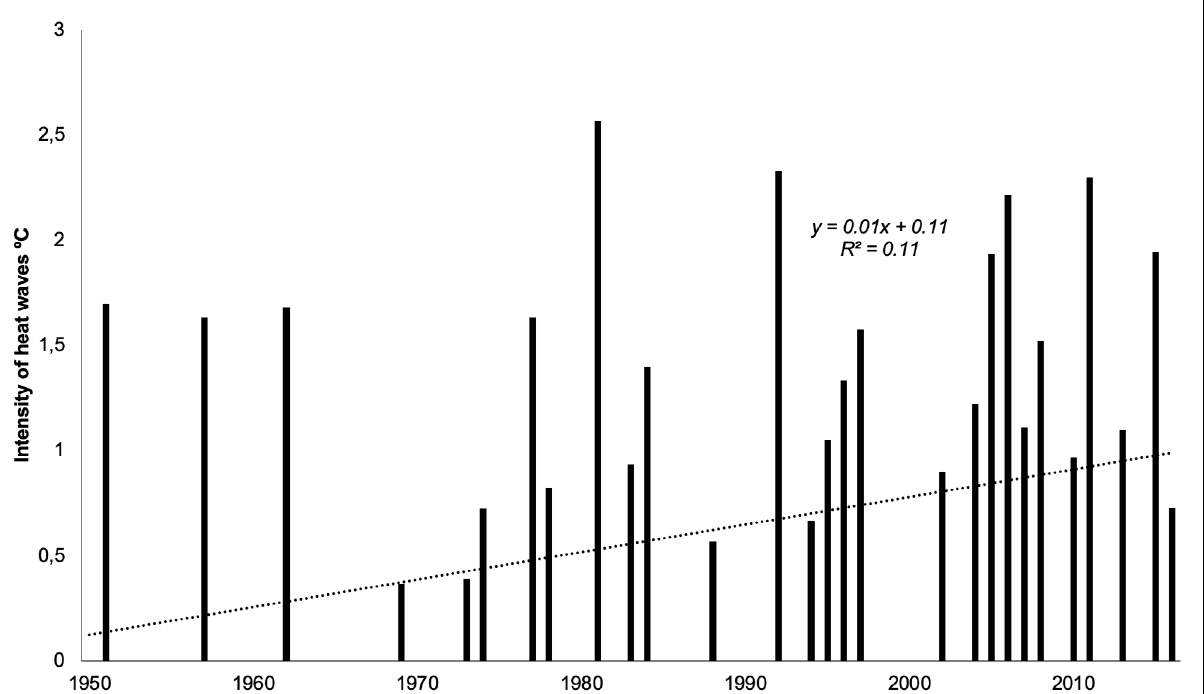
Figure 7: Intensity of heatwaves (i.e. average yearly exceedance temperature of heatwave threshold during heatwave days) for northernmost Limpopo Province, plotted against time for the period